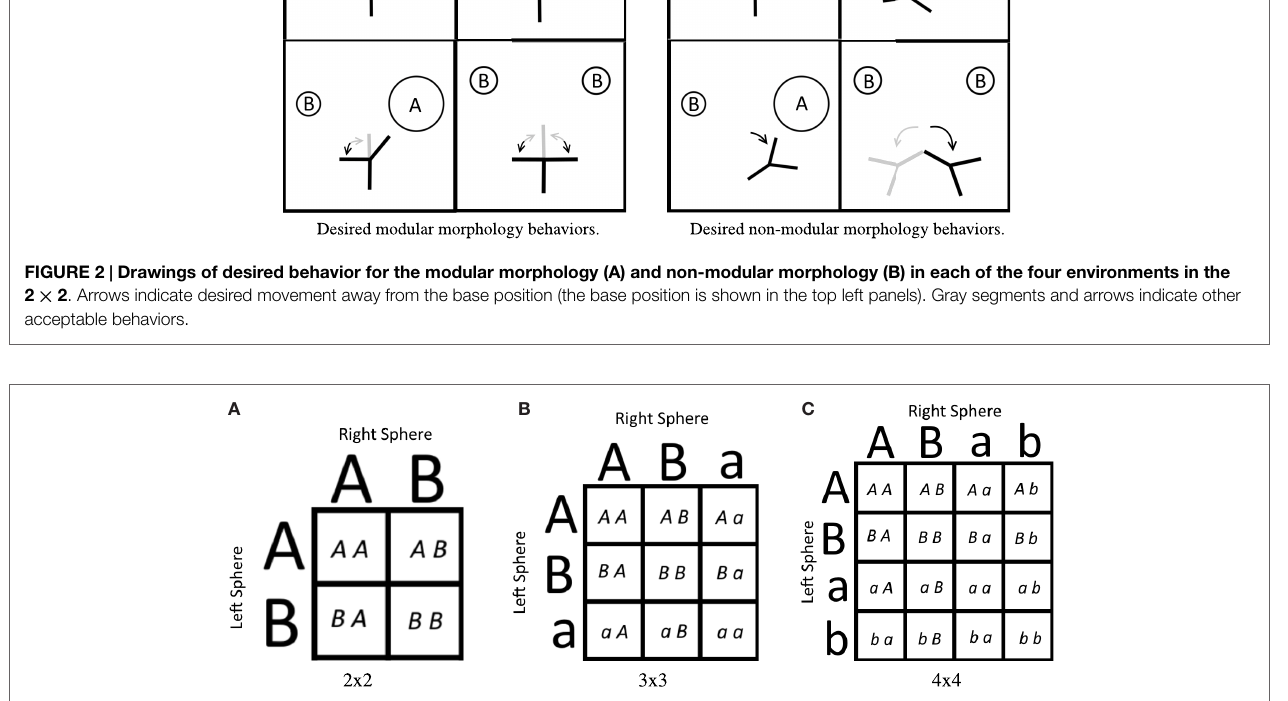
FIGURE 3 | The three environment spaces considered . A , B , a , and b represent spheres positioned on the left or right of the robot. Uppercase letters represent bigger spheres than their lowercase counterparts. Robots were evolved to “point” at A = { A , a } spheres and away from B = { B , b } spheres. (A) represents the 2 (cid:2) 2 environment space, (B) represents the 3 (cid:2) 3 environment space, and (C) represents the 4 (cid:2) 4 environment space.